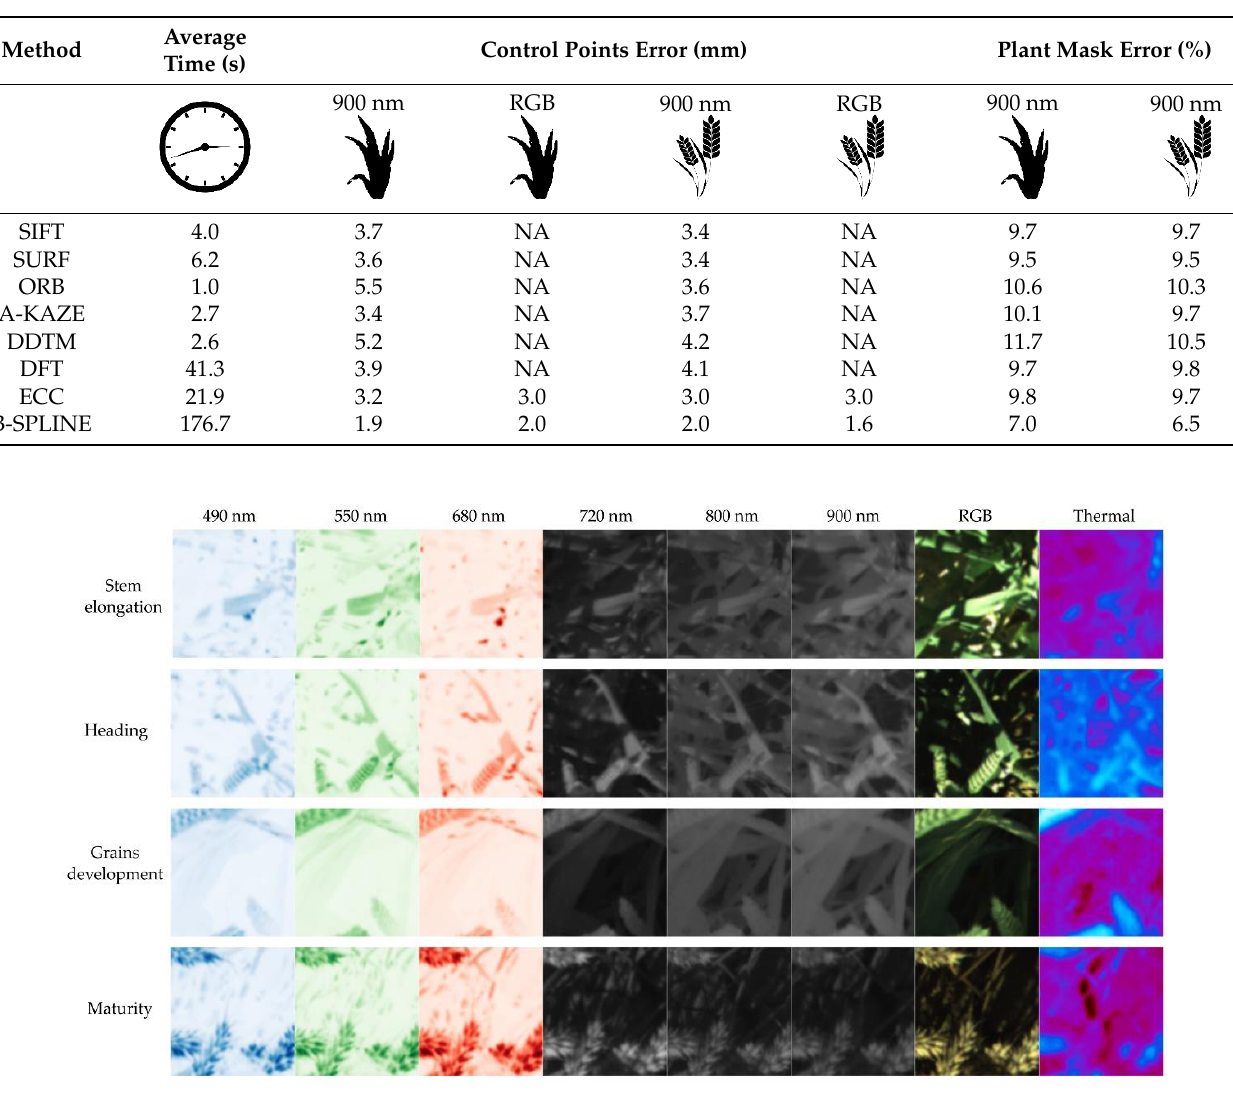
Figure 9. Illustration of registered images for all the cameras and at four wheat development stages. Thermal images have been registered using the ECC method the other using the B-SPLINE method. Images and images regions presented here have been randomly selected to avoid an operator selecting only pretty regions.